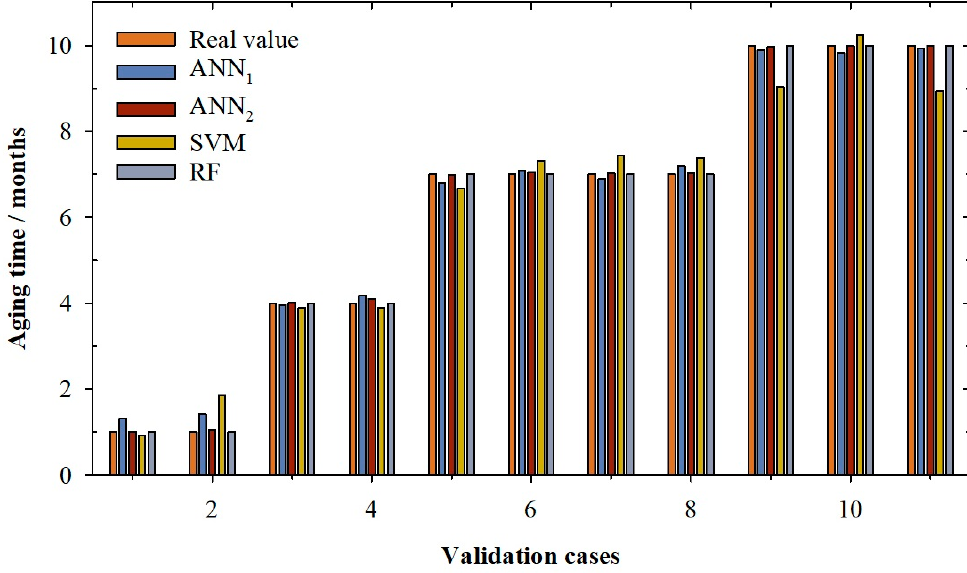
Figure 1. Bar graph for validation cases according to the real value of aging time (light brown) and the values predicted by the artificial neural network with linear function in output neuron (ANN 1 , dark blue), artificial neural network with sigmoidal function in output neuron (ANN 2 , dark brown), support vector machine (SVM, olive) and random forest (RF, light blue).